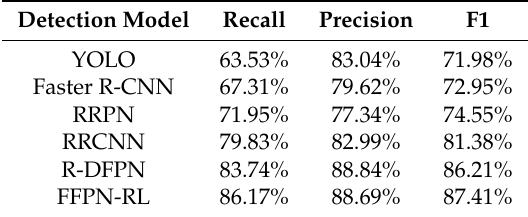
Table 3. Performance of You Only Look Once Network (YOLO) [22], Faster Regions Convolution